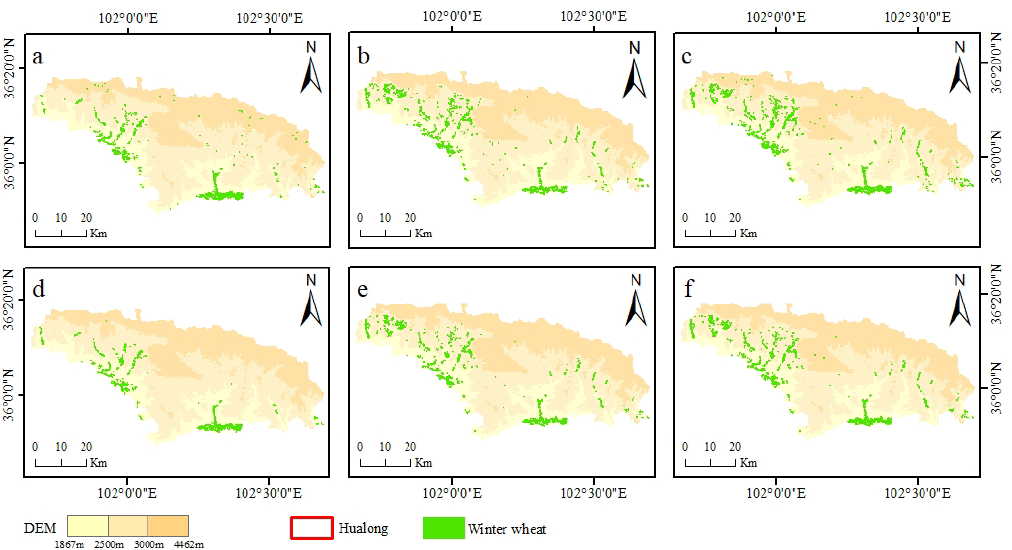
Figure 14. Extraction results with cultivated land support. ( a ) Extraction results in Plan A; ( b ) Extraction results in Plan B; ( c ) Extraction results in Plan C; ( d ) Extraction results in Plan A with cultivated land support; ( e ) Extraction results in Plan B with cultivated land support; ( f ) Extraction results in Plan C with cultivated land support. Table 8. Extraction results from cultivated land support of the first two phenological periods.